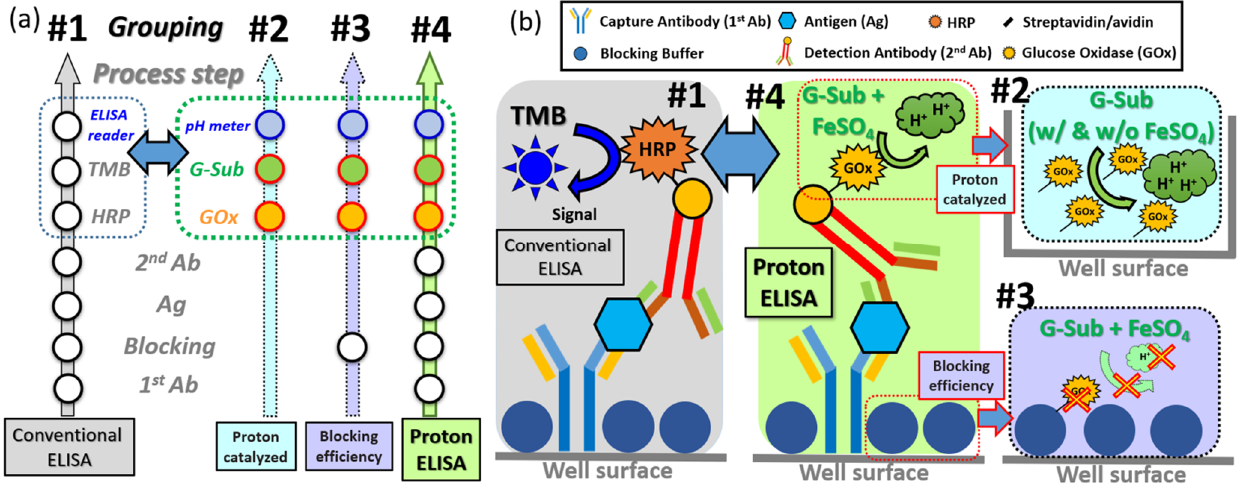
Figure 1. ( a ) Process flow design and ( b ) its schematic plot for ELISA, Proton-ELISA and the partitional experiments from part #1 to part #4.